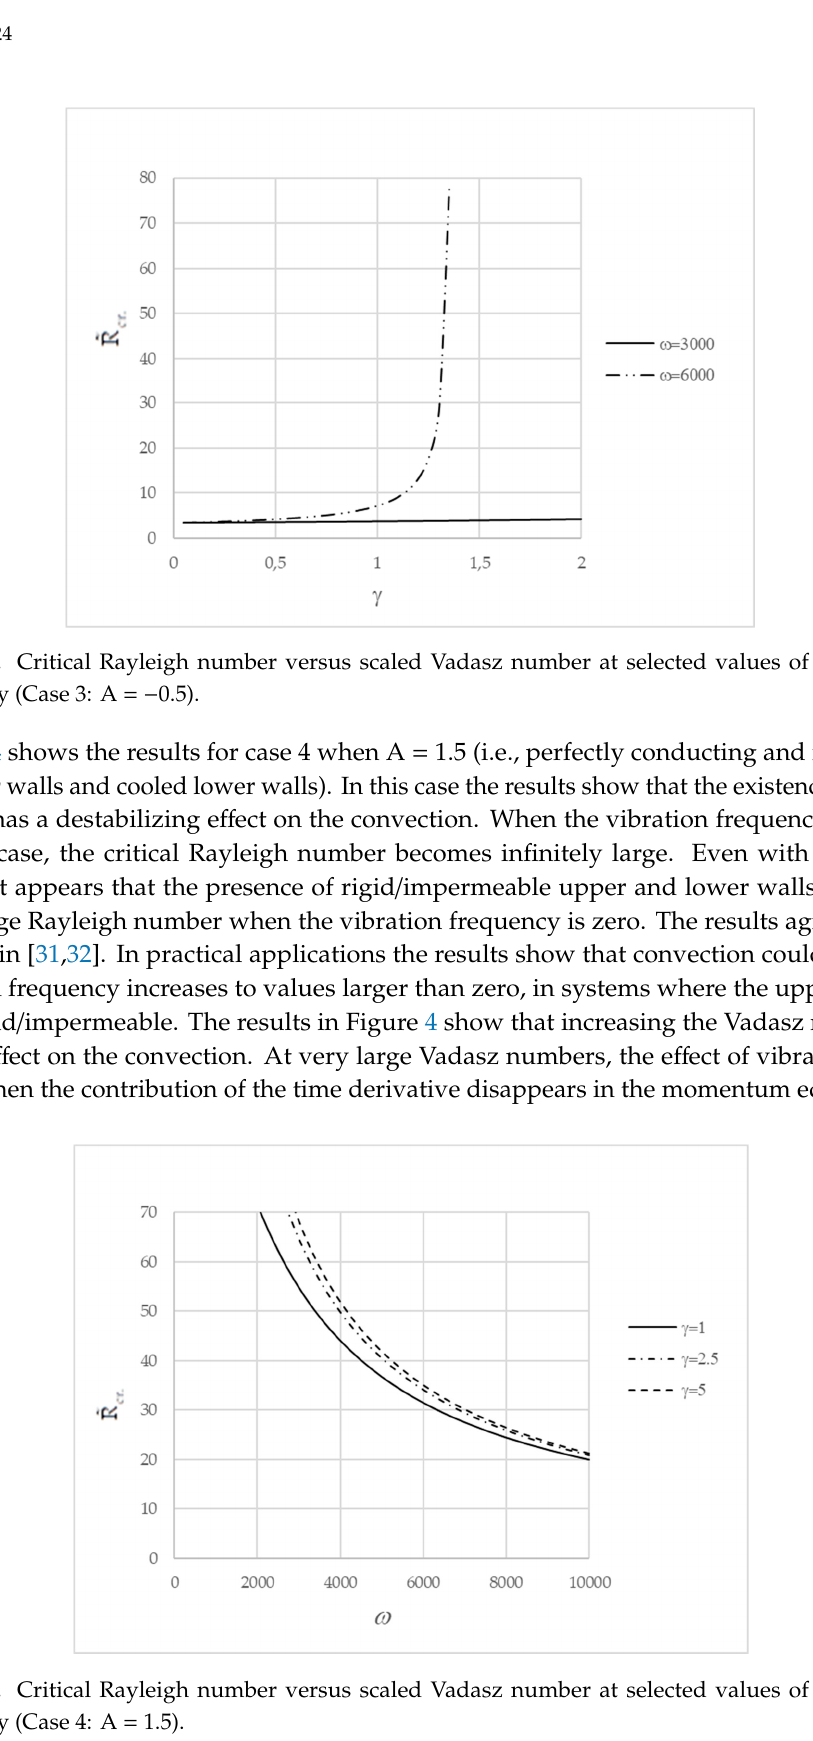
8 of 12 Figure 2. Case 3: Critical Rayleigh number versus vibration frequency for selected values of Vadasz number (A = − 0.5).